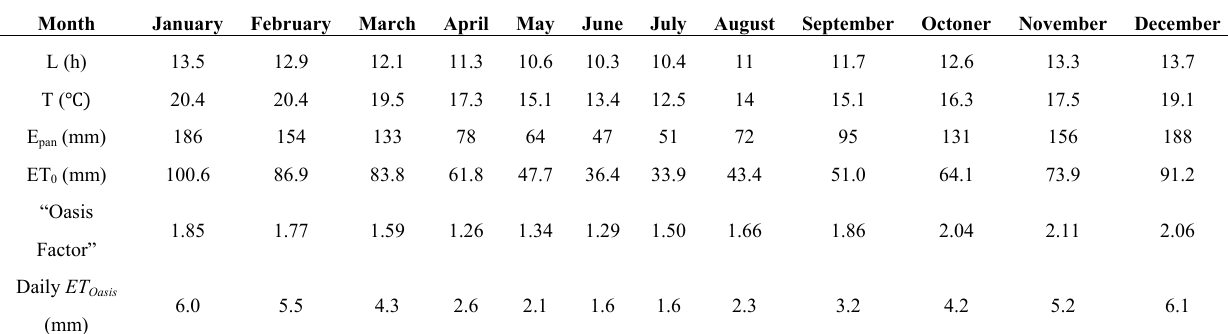
Table 3. Observed and calculated evaporation, with “oasis factor” values at latitude (28º S) for the Lautaro reservoir